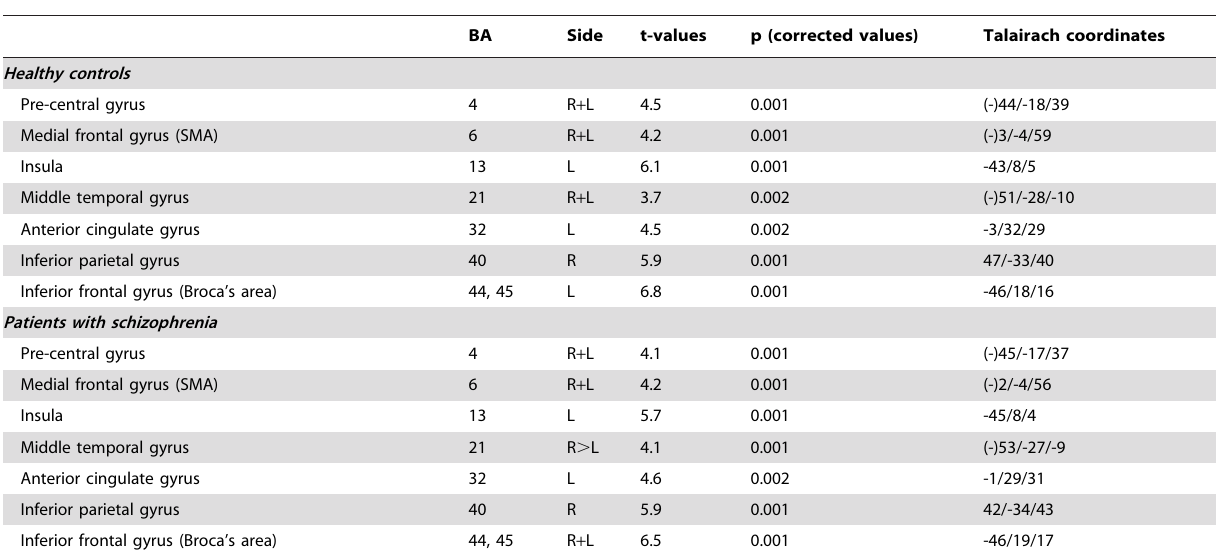
Table 2. Cortical areas involved in the identification of intelligible speech in healthy controls and patients with schizophrenia.